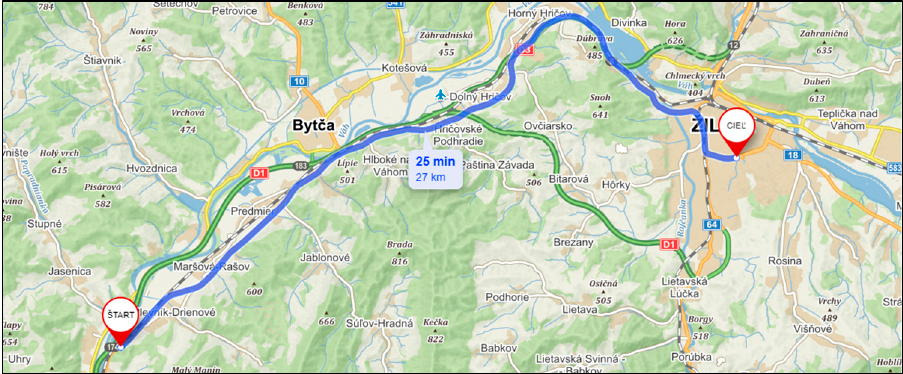
Figure 3. Description of the measuring route—driving outside the city (online maps: Mapy.cz).